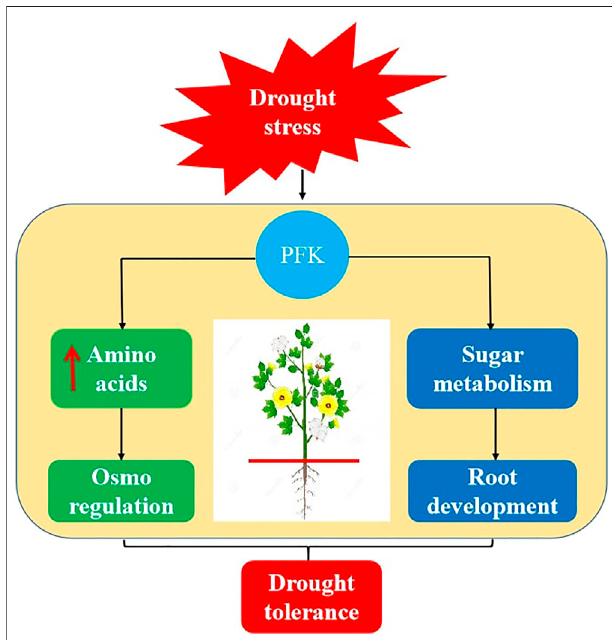
FIGURE 10 | A graphic model for the role of PFK genes under drought stress. Drought stress induces biosynthesis and upregulation of amino acids production and activates the plant osmo regulation activity. Additionally, PFK involves in sugar metabolism and acts as the energy source for root development during plant drought stress